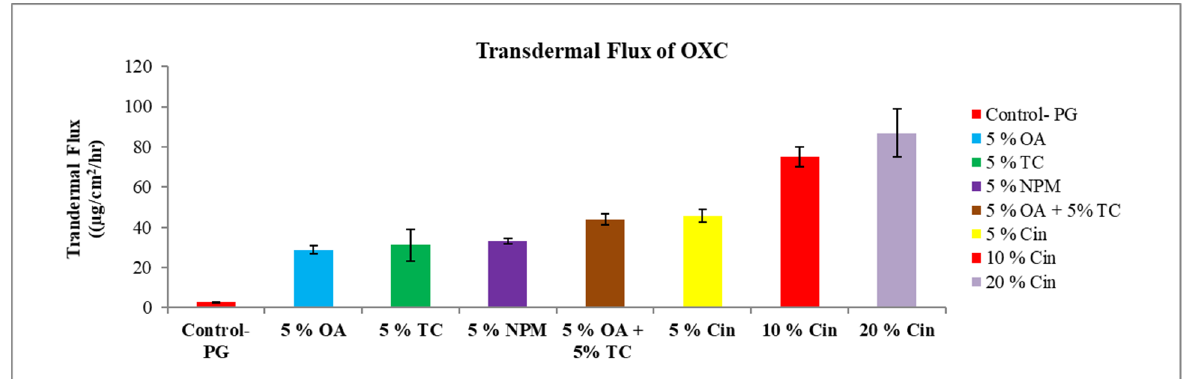
Figure 6. Transdermal flux of OXC across human cadaver skin in the presence or absence of different penetration enhancers. Each point represents the mean ± S.D. of three replicates in the absence of multiple donors.